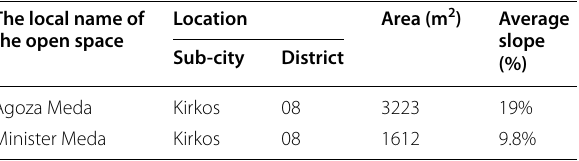
Table 4 Available open spaces that are not claimed by other functions at the